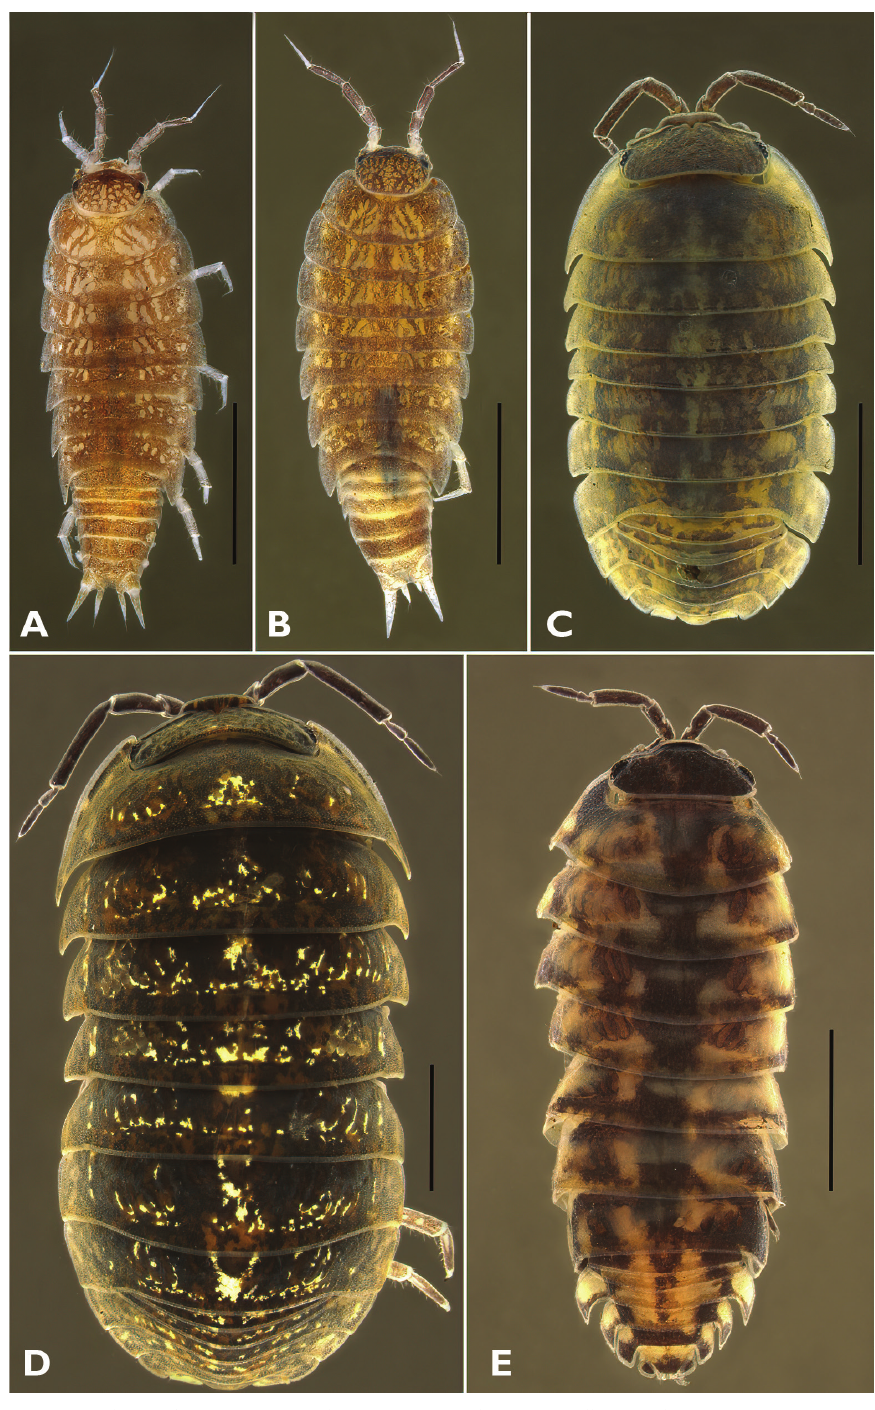
Figure 3. Habitus of Estonian Oniscidea species A Trichoniscus pusillus B Hyloniscus riparius C Armadil- lidium zenckeri D Armadillidium opacum E Armadillidium pulchellum . Scale bars: 1